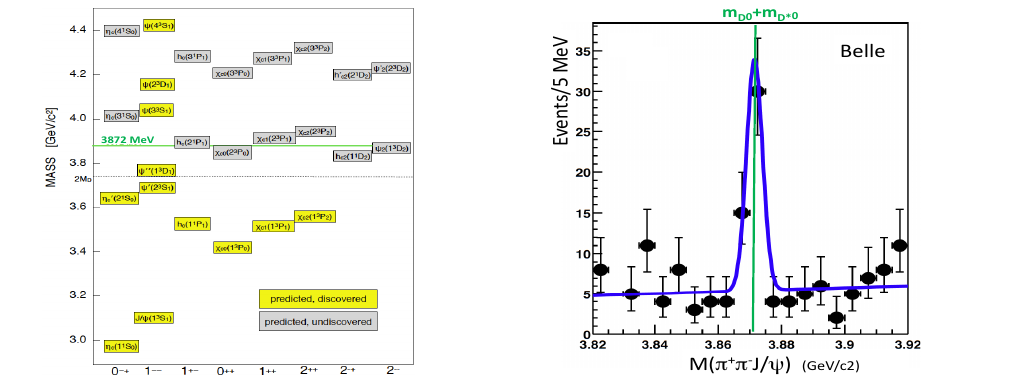
Figure 1. The charmonium spectrum circa 2003. Figure 2. The X (3872) signal with all the Belle data